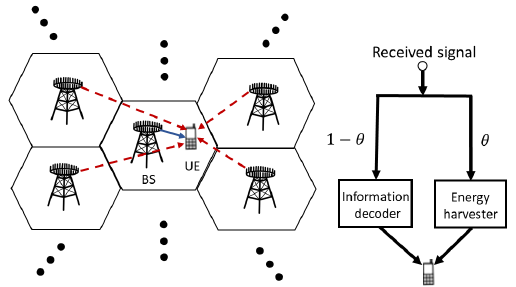
Figure 1. An example of a MISO SWIPT-enabled wireless IoT network